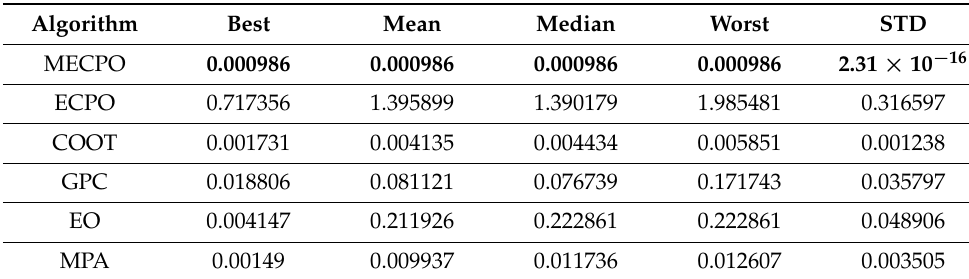
Table 7. Statistical results of the proposed MECPO algorithm and other recent algorithms in the case of the SDM.